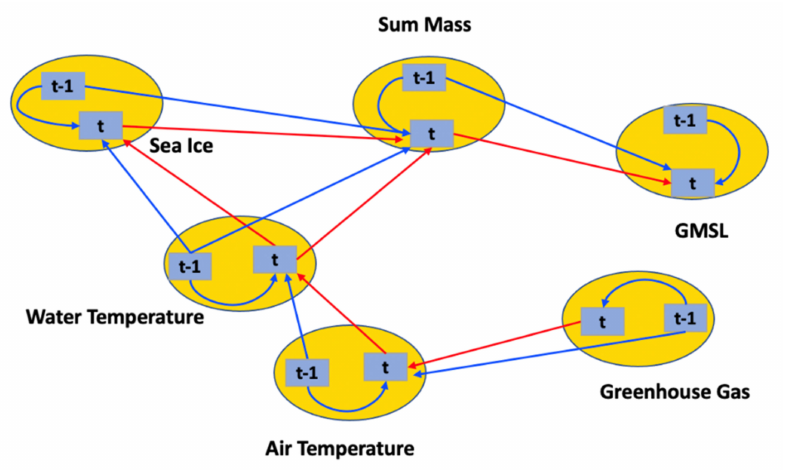
Figure 3. Hypothesized path diagram for the dynamic structural equation [VAR(1)-SEM] model. Here, red lines represent contemporaneous relationships while blue lines represent longitudinal relationships. ‘GMSL’ represents the monthly global mean sea level. ‘Sum Mass’ represents the combined Greenland and Antarctic (land) Ice Sheet monthly mass losses. ‘Sea Ice’ refers to the monthly average sea ice extent in the Northern Hemisphere. See Table 1 for more variable